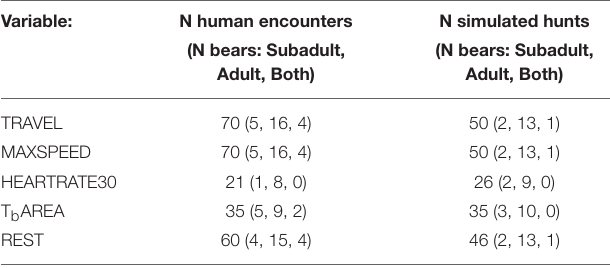
TABLE 1 | Number of human encounters and simulated hunts with complete data sets.